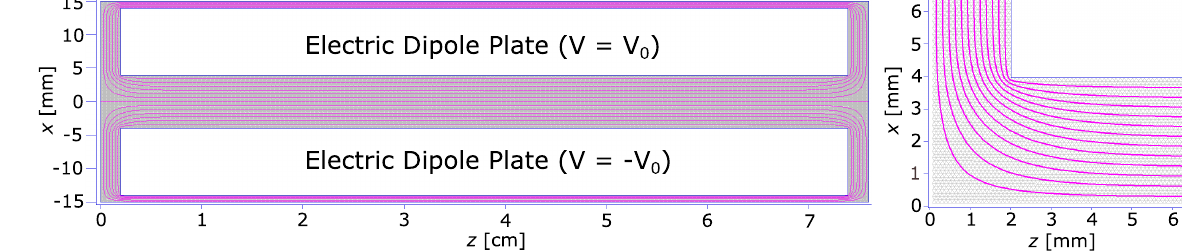
FIG. 13. Potential contours of the FRIB Allison scanner in Fig. 1, including details of the fringe structure in the vicinity of the entrance slit (right).